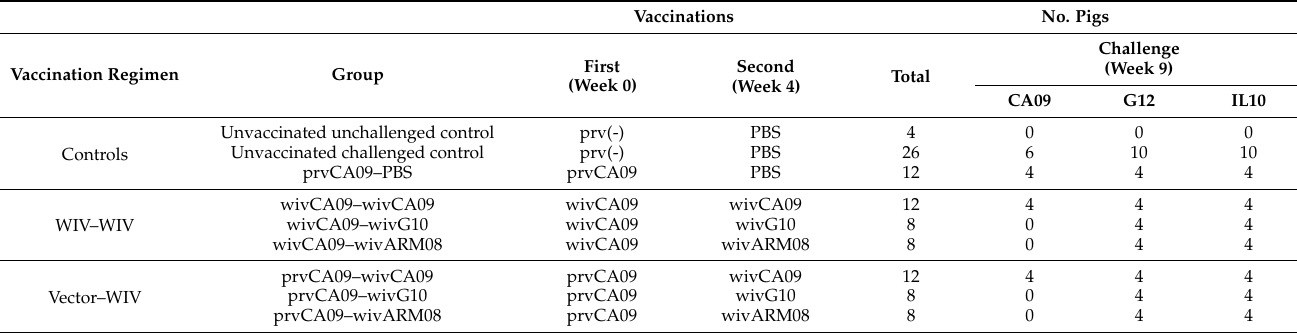
Table 1. Experimental design of experiment